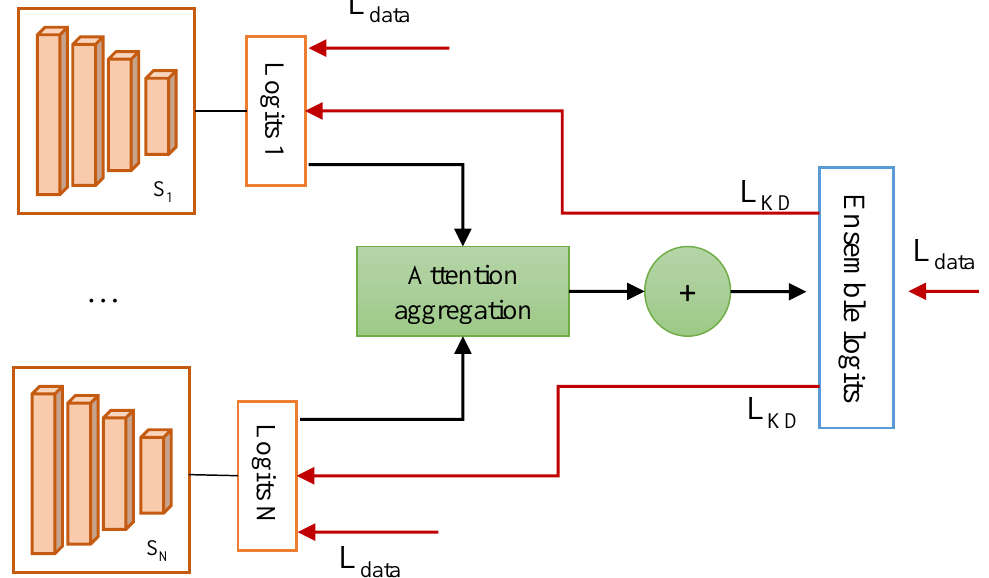
Figure 1. Solution outline. The proposed framework simultaneously trains a group of student peers and learns from the peers’ predictions. The red arrows indicate the loss terms applied to each output: L data —the standard cross-entropy loss; L KD —the knowledge distillation